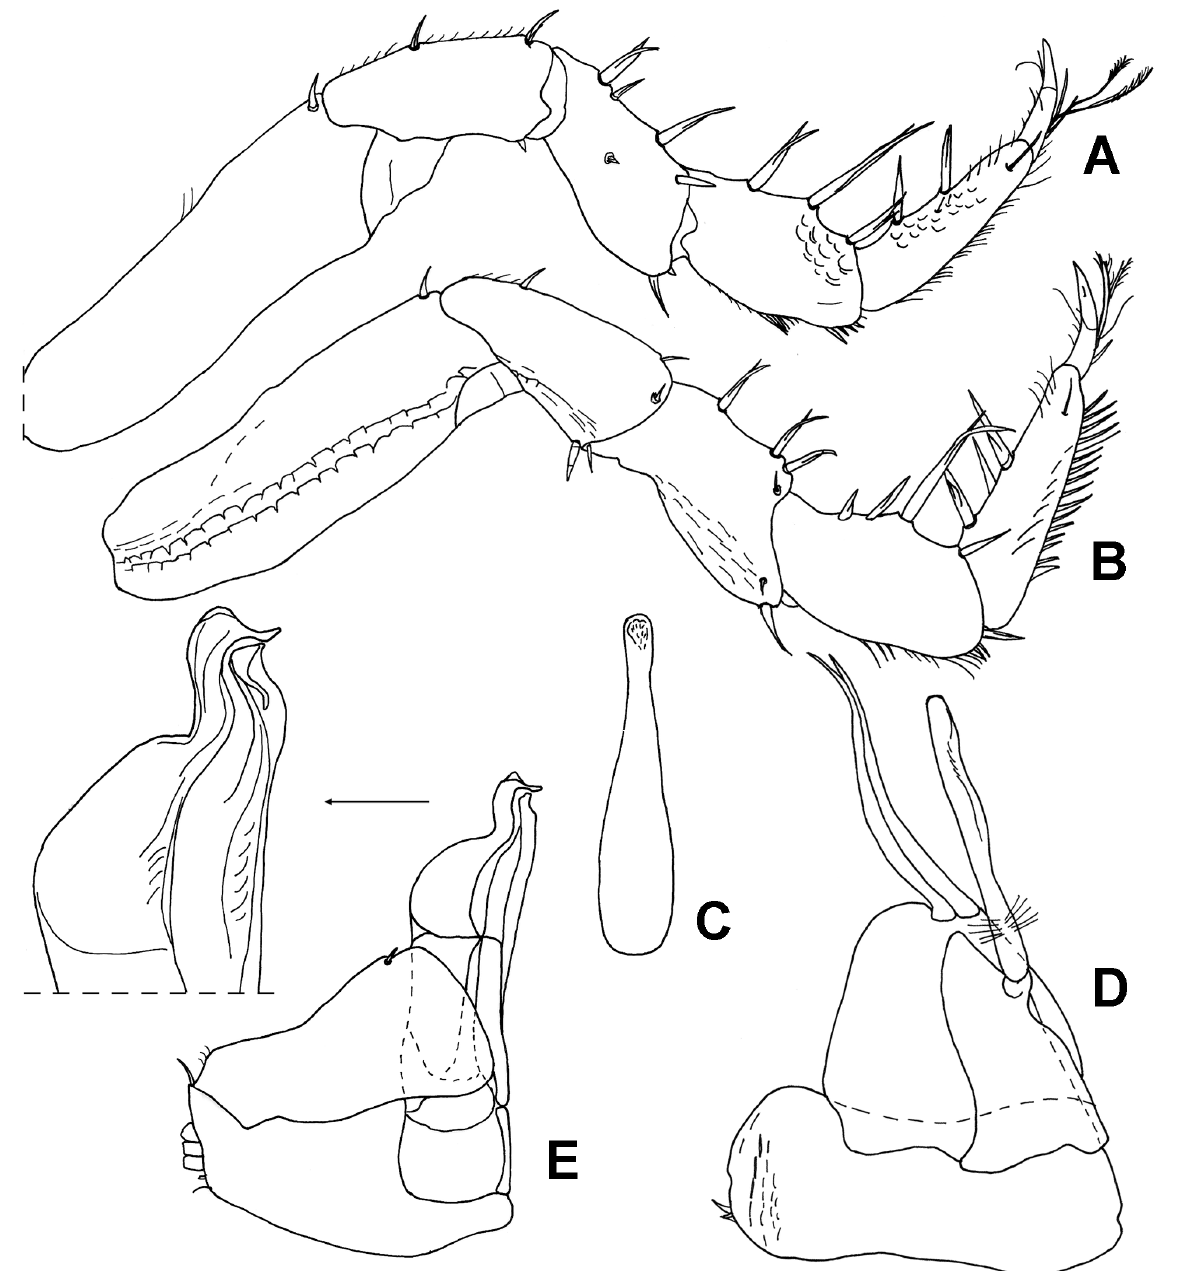
Fig. 12. Metatrichoniscoides salirensis Reboleira & Taiti sp. nov. from Gruta de Salir, Caldas da Rainha, paratype, ♂. A . Pereopod 1. B . Pereopod 7. C . Genital papilla. D . Pleopod 1. E . Pleopod